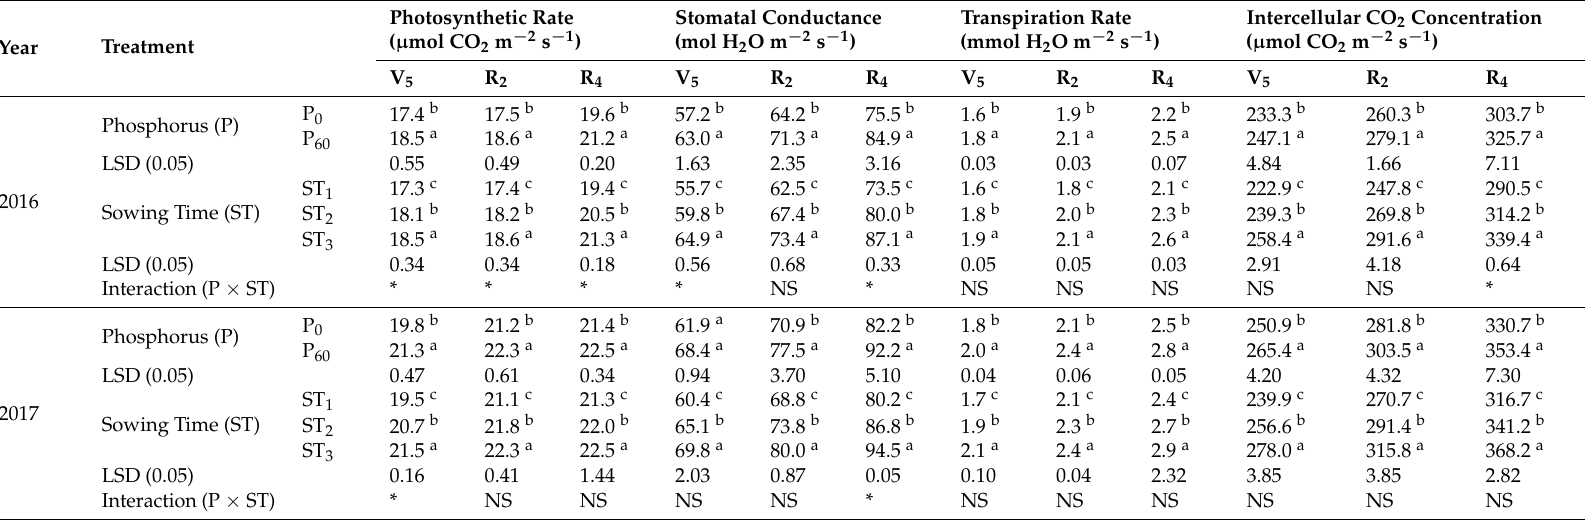
Table 3. Effect of sowing times and phosphorus fertilizer rates on photosynthetic characteristics of soybean at three stages of phenological development in relay intercropping system with maize during the cropping seasons of 2016 and